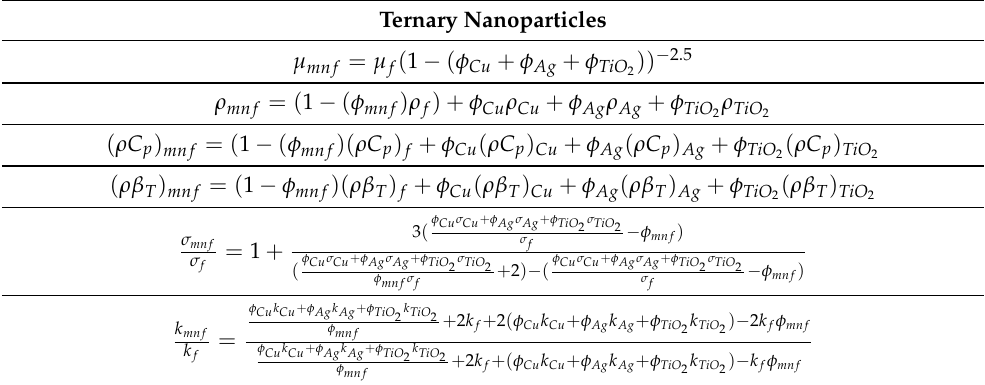
Table 1. Thermo-physical properties of ternary nanoparticles [34]. Ternary Nanoparticles